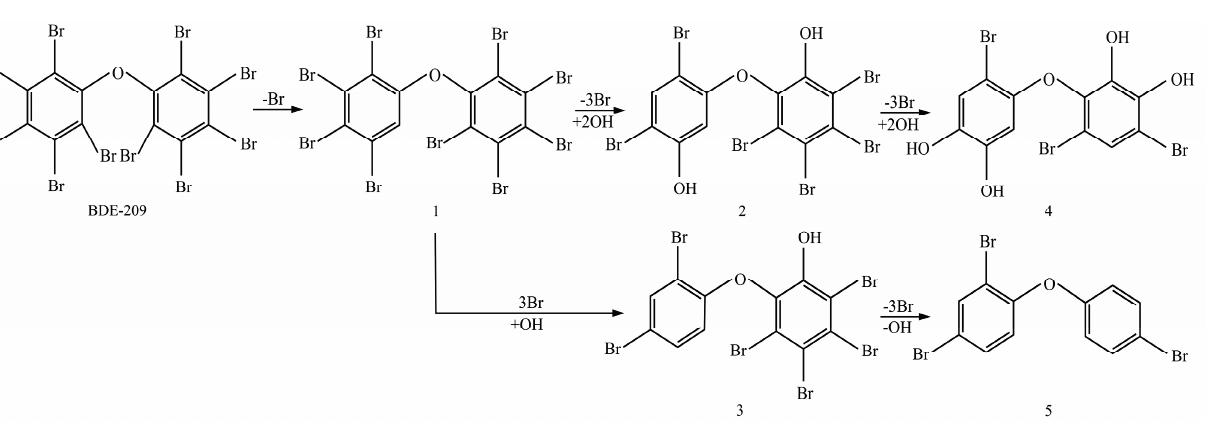
Figure 5. A possible BDE-209 biodegradation pathway by crude enzyme extract. 1–5 were possible BDE-209 biodegradation products listed in Table